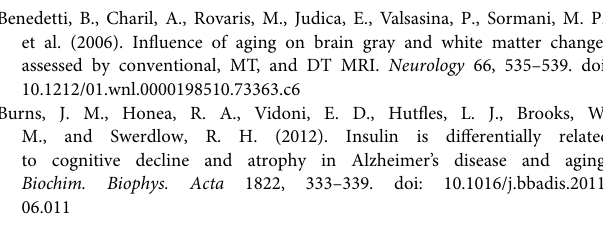
FIGURE 2 | Associations of OGTT parameters with gray and white matter MTR peak height in offspring and control groups, stratified for age. Forest plots showing the distribution of the association of OGTT parameters (fasted glucose, AUC glucose , fasted insulin, AUC insulin , and HOMA-IR) with MTR peak height in gray and white matter in offspring and